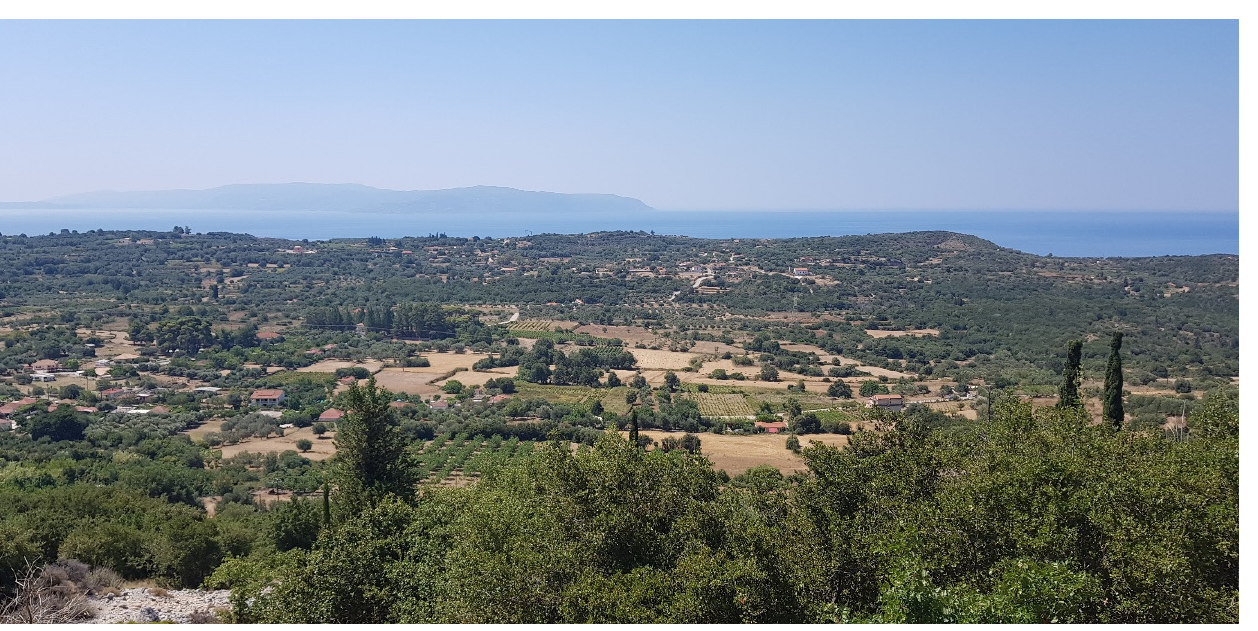
Figure 8. Panoramic drone image of a prominent Terrace II palaeosurface at 145 m asl (view South) east of Thiramonas village.